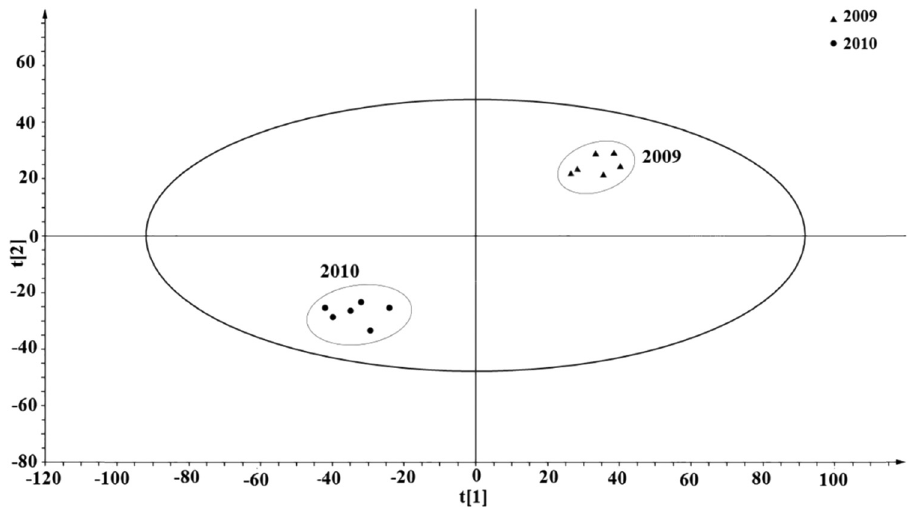
Figure 3: PLS - DA score plot chart from 1 H NMR spectra of 2009 and 2010 vintage Cabernet Sauvignon wines.